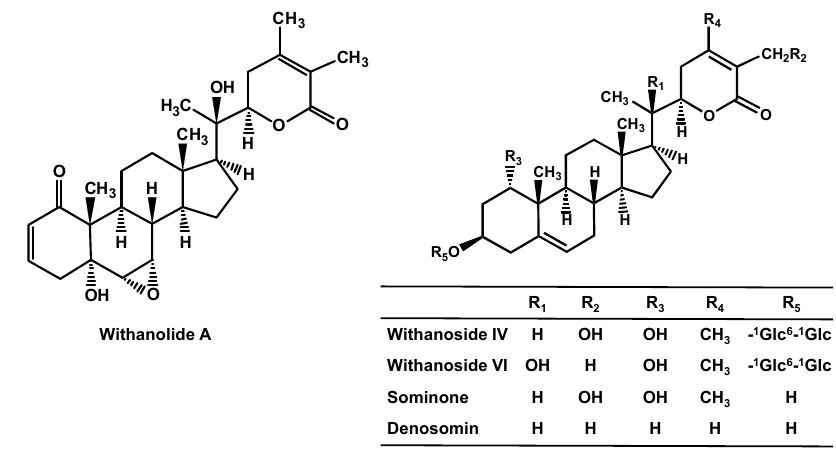
Figure 2. Structures of Ashwagandha-related compounds.